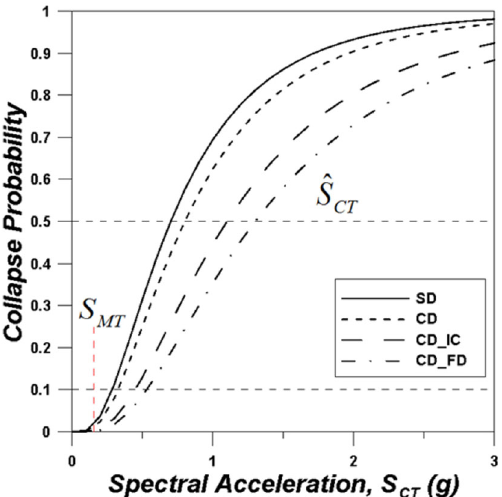
Fig. 23 Fragility curves of the model structures for reaching the state of dynamic instability.